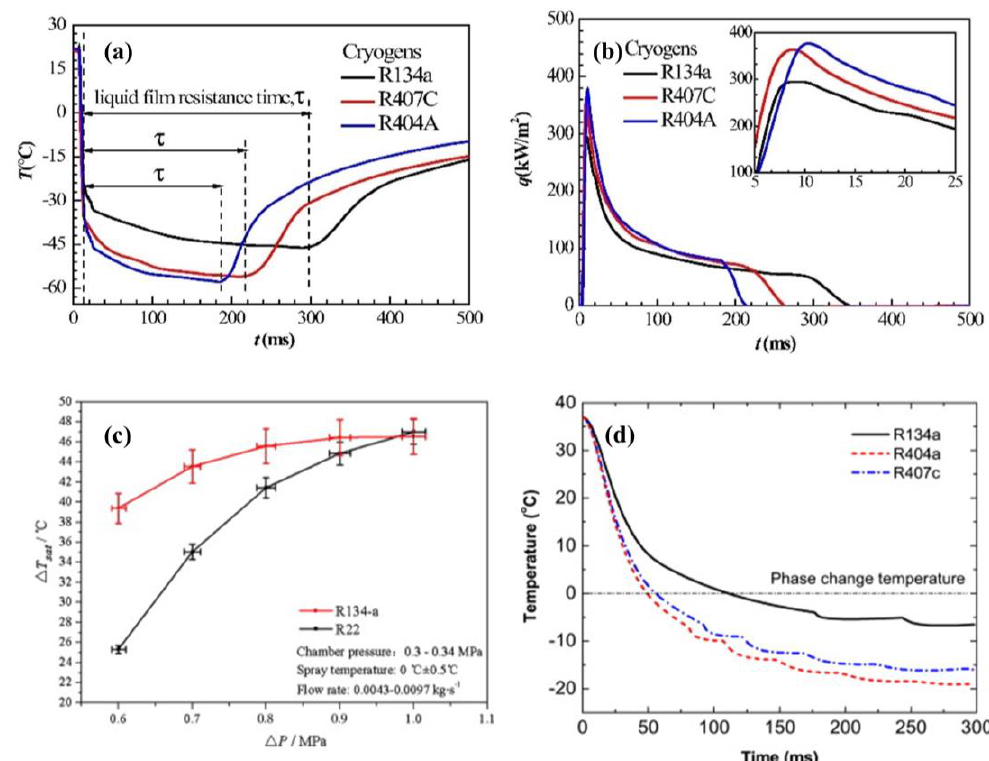
Figure 5. Analysis of the impact of working medium on heat exchange performance during spray cooling. Variations of surface temperature ( a ) and heat flux ( b ) with R134A, R407C, and R404A [93]. ( c ) The cooling temperature of R22 and R134A spray cooling system at CHF [92]. ( d ) Dynamic variation of epidermis/dermis interface temperature as a function of spray duration with different cryogens: R134a, R404a and R407c, respectively [91].